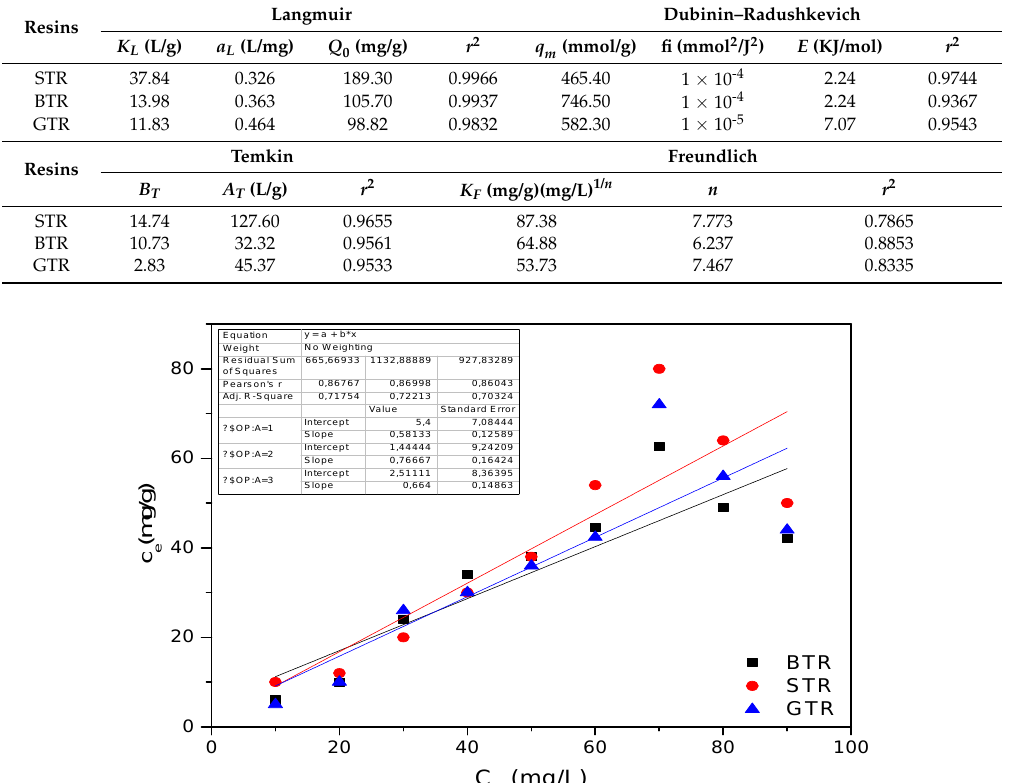
Table 4. Comparison of four isotherm equations for equilibrium uptake studies of Pb 2+ by the three resins.